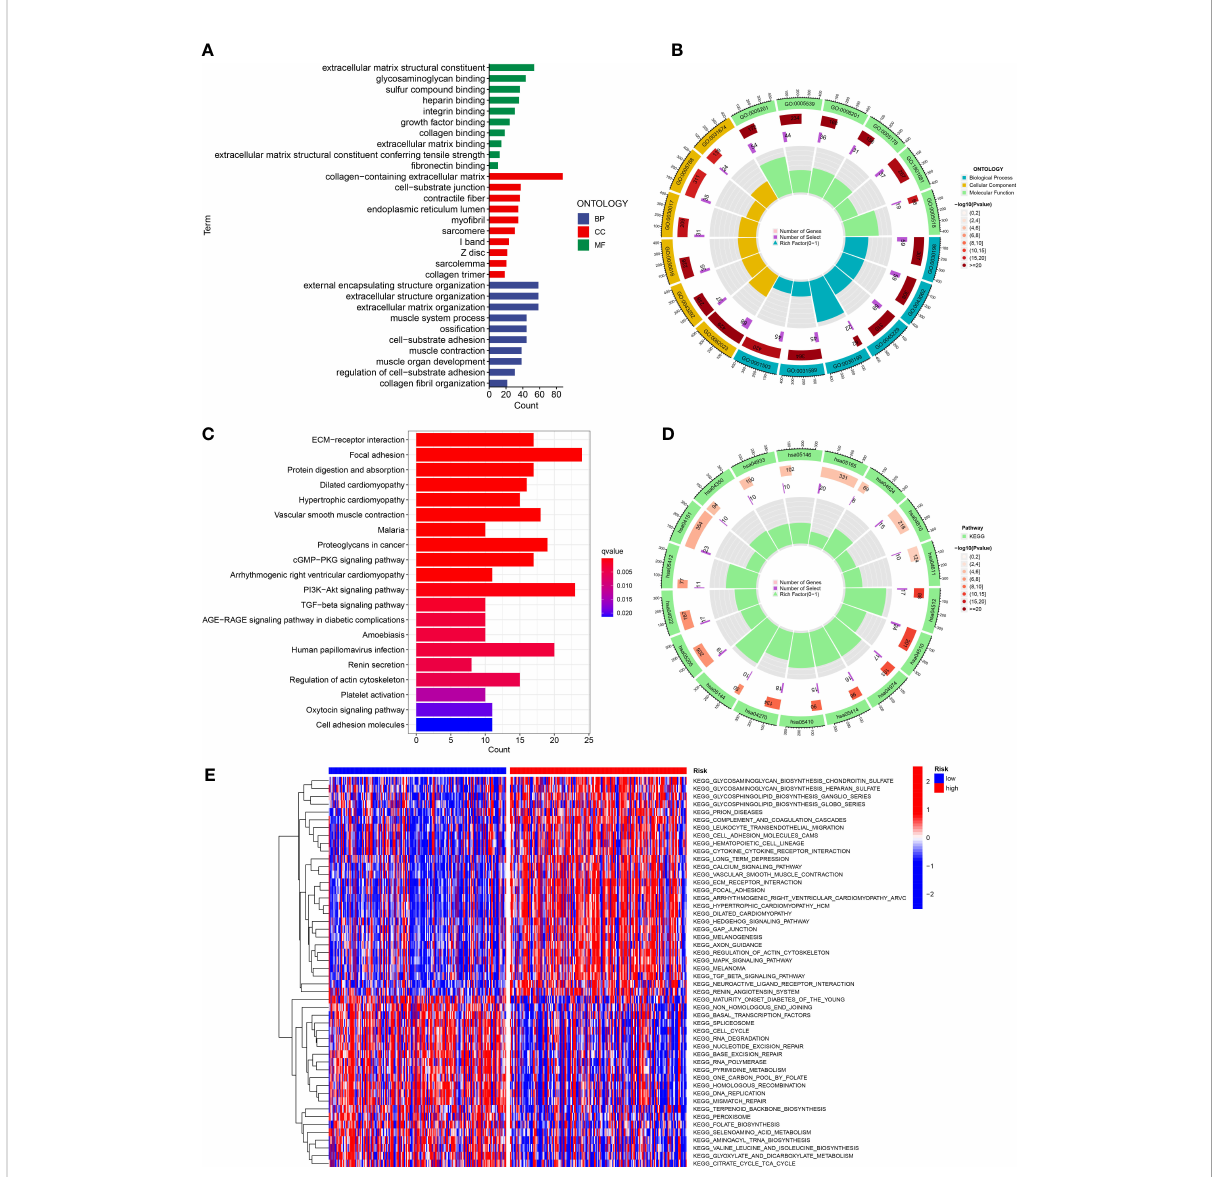
FIGURE 8 Function analysis. (A, B) GO analysis of differential genes between high and low risk groups. (C, D) KEGG analysis of differential genes between high and low risk groups. (E) GSVA enrichment analysis in high and low risk